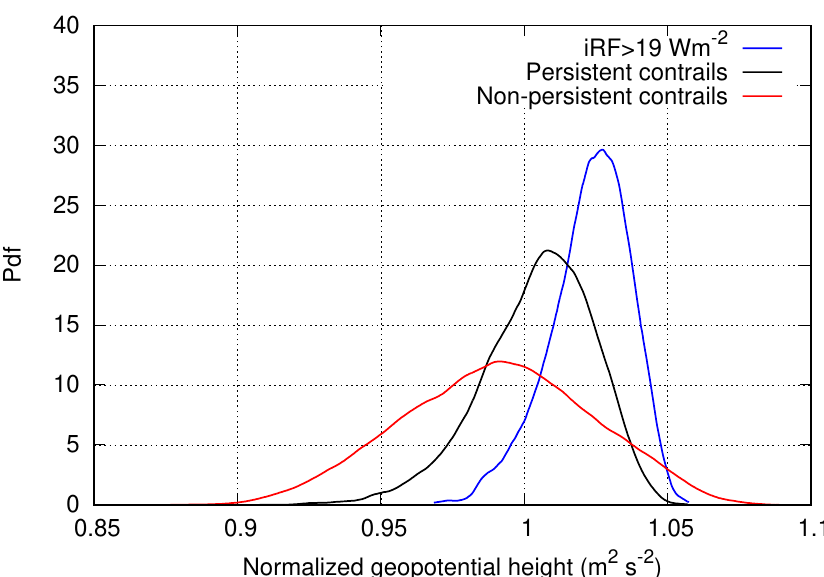
Figure 4. As Figure 1, but for vertical velocity (in pressure coordinates, upper left panel), divergence ( upper right ), relative vorticity ( lower left panel), and potential vorticity ( lower right panel).